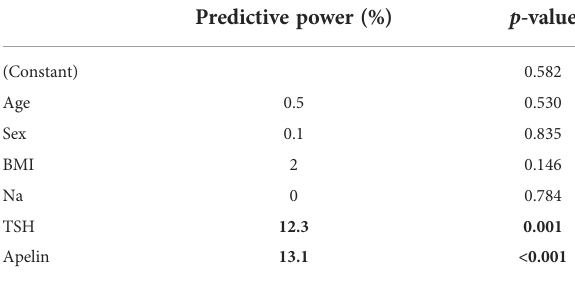
TABLE 5 A linear regression model with copeptin as a dependent